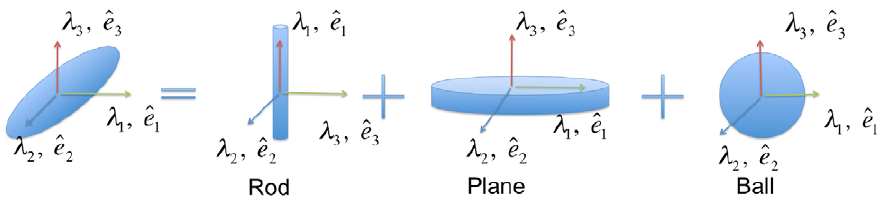
Figure 2. Tensor decomposition. A symbolic illustration of a generic tensor represented in terms of basis tensors of type plane, rod and ball.